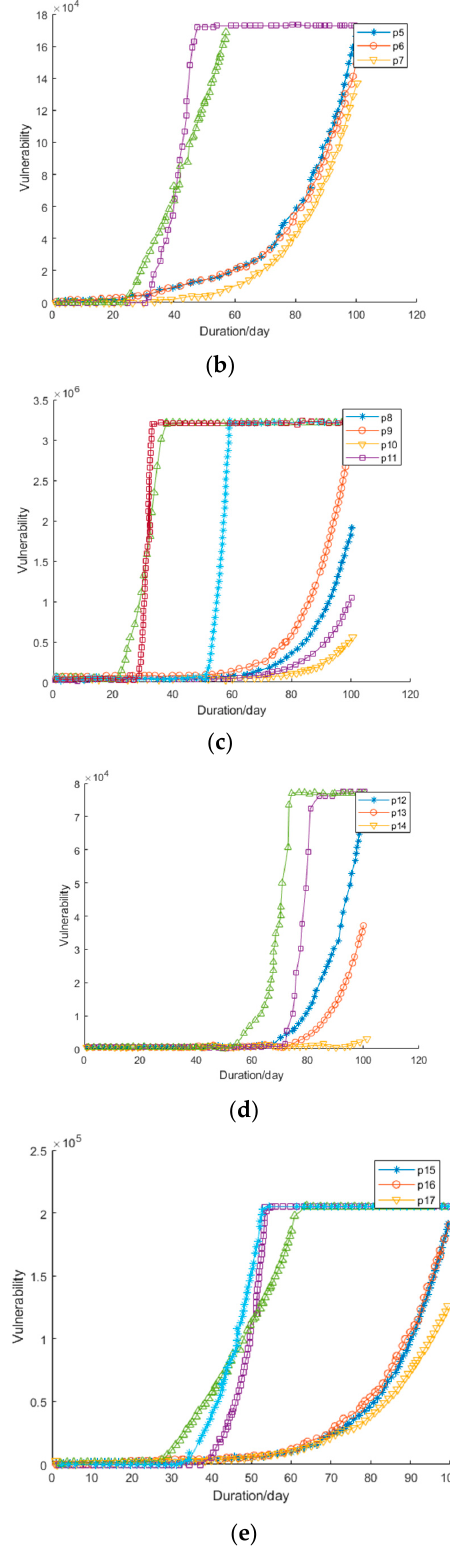
Figure 8. Vulnerability cascade propagation analysis. ( a ) Trend of place vulnerability and cascade propagation state on wind energy supply path; ( b ) trends in place vulnerability and cascade prop- agation states on geothermal energy supply paths; ( c ) trends in place vulnerability and cascade propagation states on solar power paths; ( d ) trend of place vulnerability and cascade propagation state on the external transmission path; ( e ) trend of place vulnerability and cascade propagation state on the battery supply path.The purple and green lines are both controls for each group.